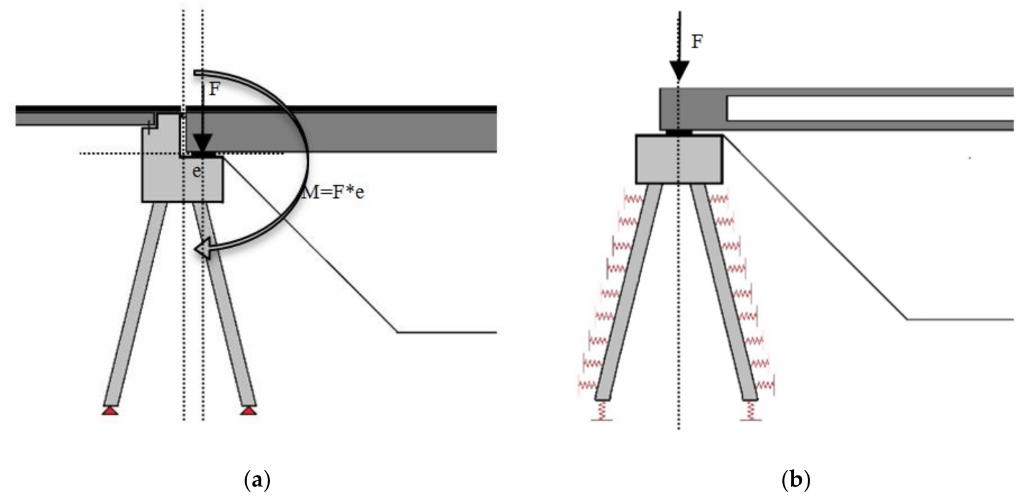
Figure 14. ( a ) Existing and ( b ) new bridge foundation